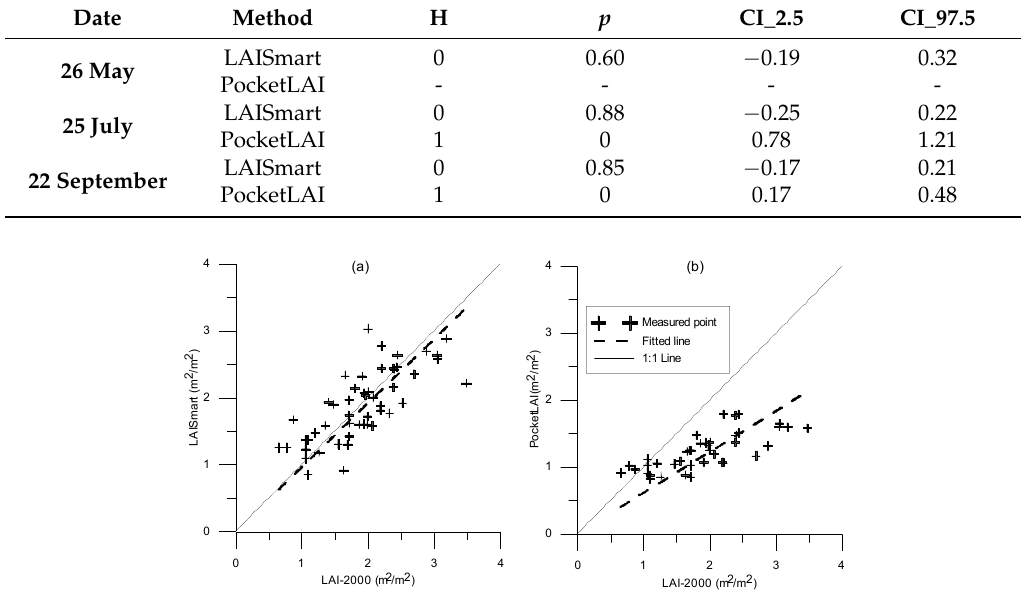
Figure 3. Scatter plot of the measurements of two smartphone sensors method with the data of LAI-2000 using all the data collected during the experiment period. Table 5. Regression parameters and the evaluation metrics of the two smartphone sensor methods compared with references LAI.